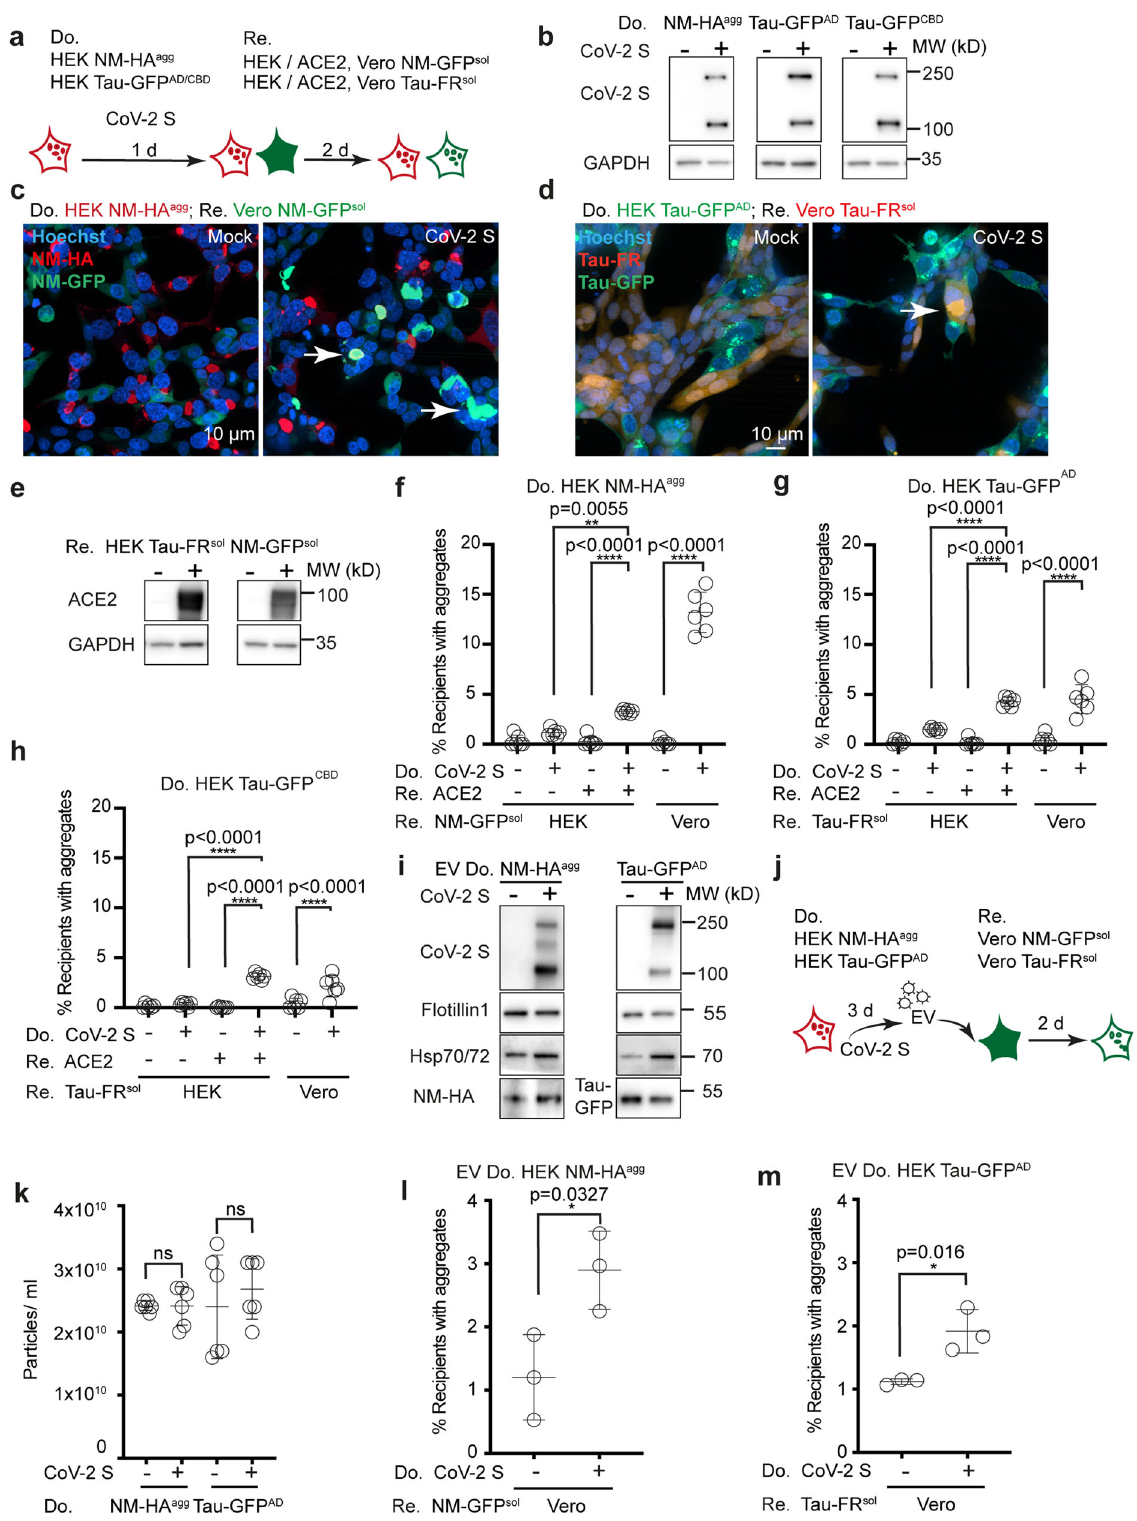
Western blotting . For Western blot analysis, protein concentrations were mea- Alix (1:1000; BD Bioscience); rat anti-HA 3F10 (1:1000; Roche); mouse anti- GAPDH 6C5 (1:5000; Abcam); mouse anti-Hsc/Hsp70 N27F3-4 (1:1000; ENZO); sured by Quick Start TM Bradford Protein assay (Bio-Rad) using the plate reader mouse anti-VSV-G 5D4 (1:1000; Sigma); rat anti Sup35 M domain (1:10; hybri- Fluostar Omega BMG (BMG Labtech) and the corresponding MARS Data Analysis doma supernatant); 88 rabbit anti-Tau ab64193 (1:1000; Abcam); rabbit anti- Software (BMG Labtech). Proteins were separated on NuPAGE ® Novex ® 4 – 12 % Bis-Tris Protein Gels (Life Technologies) followed by transfer onto a PVDF Flotillin 1 ab133497 (1:1000; Abcam); mouse anti-SARS-CoV-2-spike S membrane (GE Healthcare) in a wet blotting chamber. Western blot analysis was GTX632604 (1:1000; GeneTex); rabbit anti-hACE2 ab15348 (1:1000; Abcam); performed using mouse anti-LDL receptor (1:500; NovusBiologicals); mouse anti- rabbit anti-clathrin heavy chain (1:1000; Abcam); rabbit anti-GFP (1:5000; NATURE COMMUNICATIONS| (2021) 12:5739